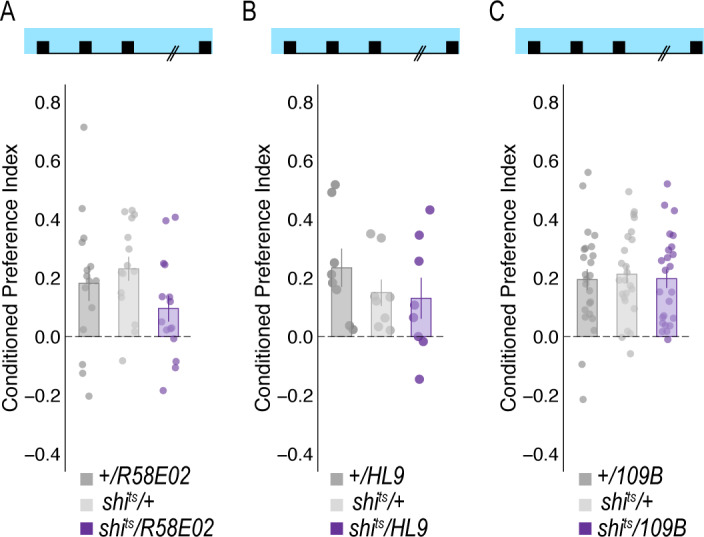
Temperature controls for DAN inhibition experiments that showed decreases in retrieval of alcohol associated preference at the restrictive temperature.Flies were trained and tested at permissive temperatures (20°C) and exhibited normal alcohol associated preference for pair odor cues under these conditions.